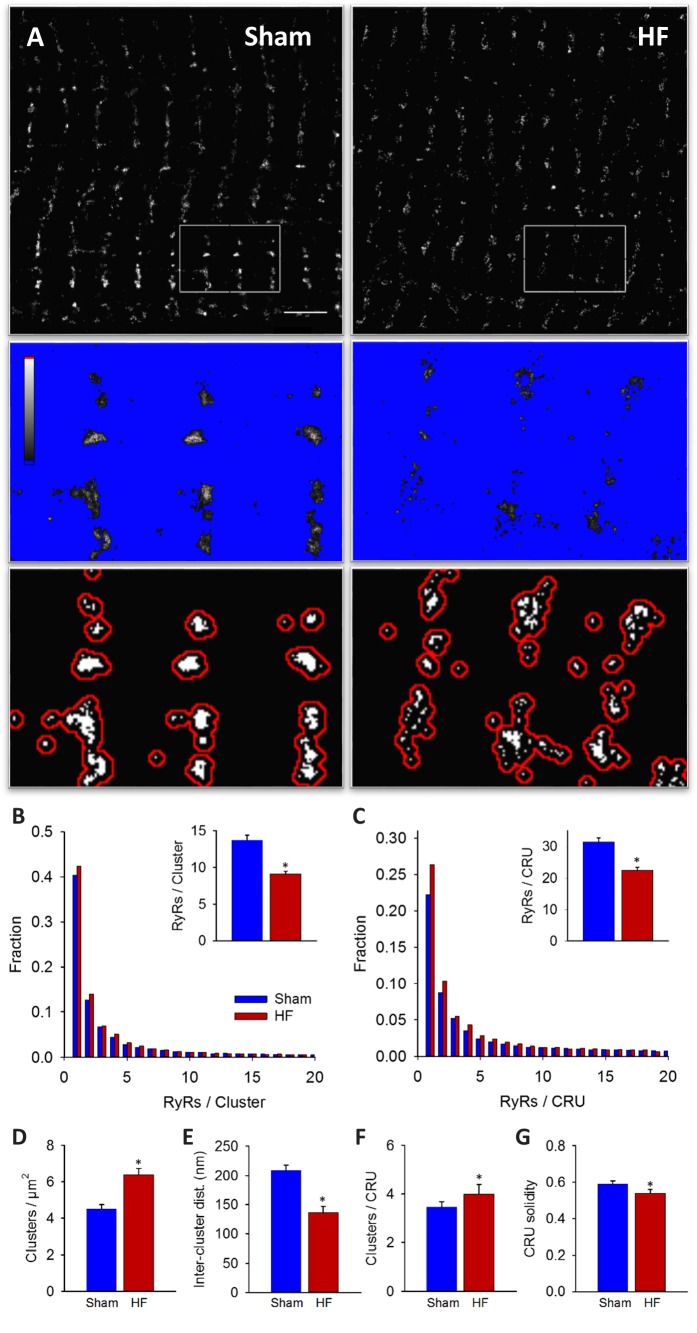
RyRs are dispersed in failing cardiomyocytes.Alterations in nanoscale RyR organization were examined in cardiomyocytes from rats with post-infarction heart failure (HF). Representative images show that macroscale organization of RyRs was similar in HF and Sham-operated controls (A), upper panels). However, nanoscale examination revealed that RyR clusters were broken apart in HF. For the magnified regions in (A), conversion from raw dSTORM to binary images is shown in the middle and lower panels (saturation levels indicated by high-low look-up table). Mean measurements showed fewer RyRs per cluster in failing cells, with an increased fraction of small clusters (B). Dispersion of RyR clusters into smaller fragments resulted in an increased overall number of clusters (D), reduced inter-cluster distances (E) and inclusion of more clusters in each CRU (F). Overall CRU composition became less solid in failing cells ((G), assessed by convex-hull analysis), as the average CRU contained fewer RyRs (C). See Figure 2—source data 1 for analysis of 100 nm vs 150 nm CRU inclusion criterion (ncells = 46, 50 in Sham, HF; *=P < 0.05 vs Sham).10.7554/eLife.39427.006Figure 2—source data 1.Quantification of RyR organization using 150 vs 100 nm CRU inclusion criteria.RyR cluster and CRU data were compared in Sham and HF myocytes, with data cumulated across cells or animals. Two CRU definitions were also compared, with maximum edge-to-edge distances of 150 nm or 100 nm. Significant differences within data cumulated across cells were determined by t-test, while data cumulated across animals were tested with linear mixed effects models (Lindstrom and Bates, 1988).